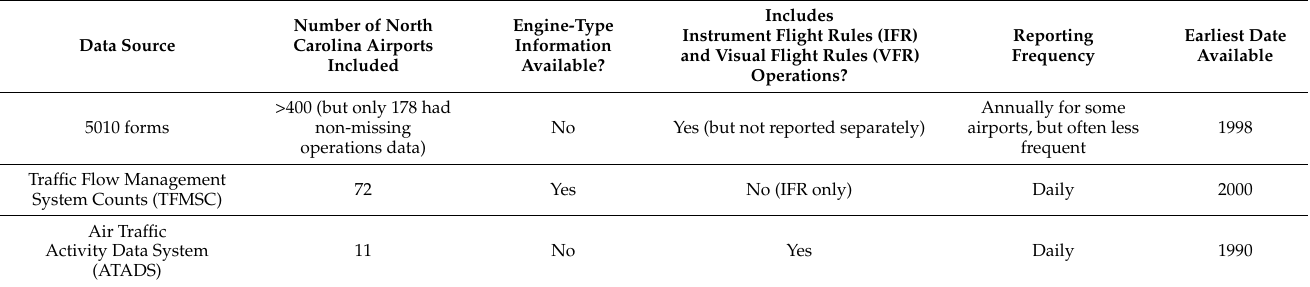
Table 1. FAA data sources for general aviation and/or piston-engine